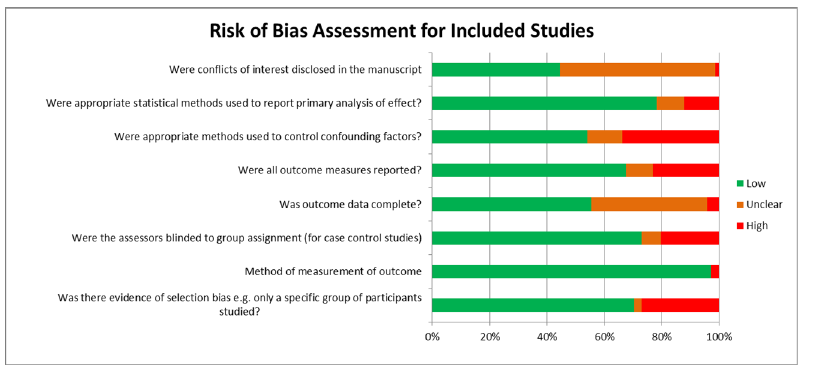
Fig 2. Quality assessment: Risk of bias assessment for included studies in meta-analysis classified as high, low or unclear.